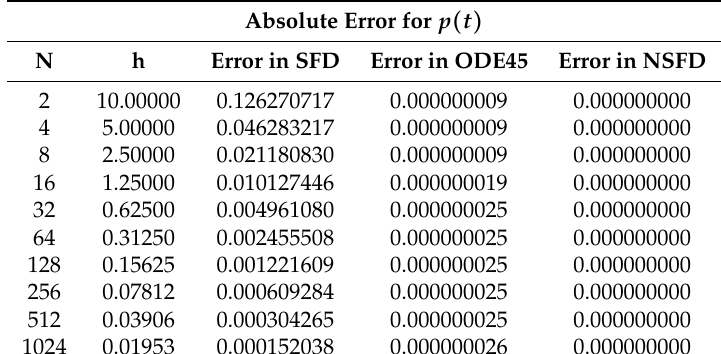
Table 3. The absolute error results for the system of equations given by (13) for p with parameter